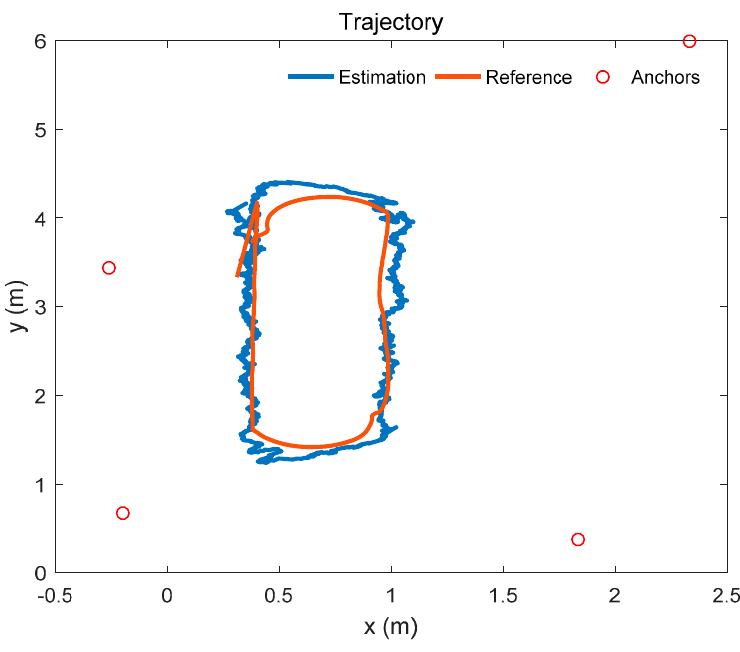
Figure 6. Trajectory of the mobile robot.